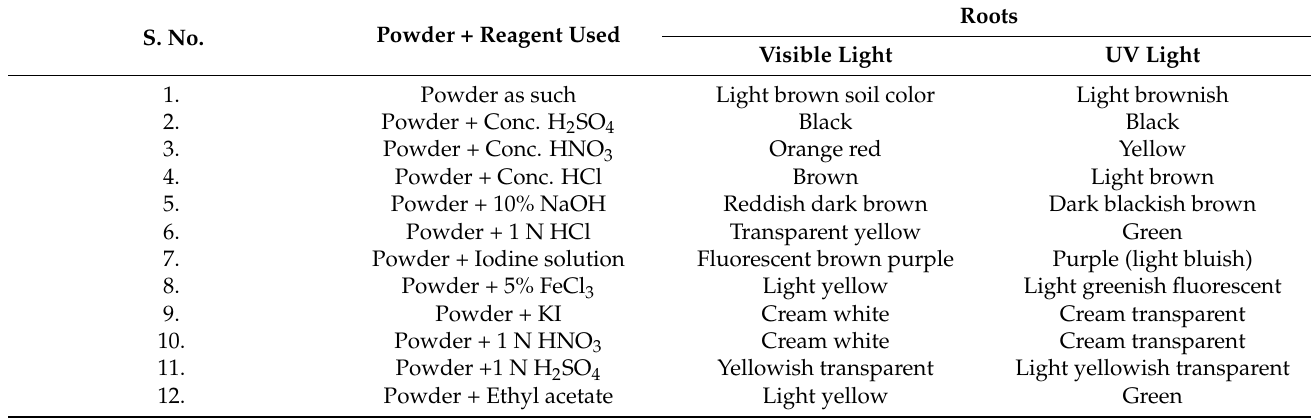
Table 4. Fluorescent behavior of N. triquetra stem powder upon treatment with different chemical reagents. S.